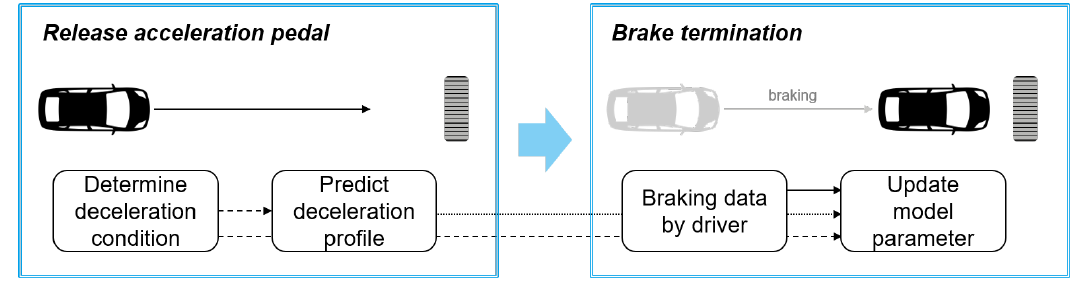
Figure 1. Algorithm operation process.